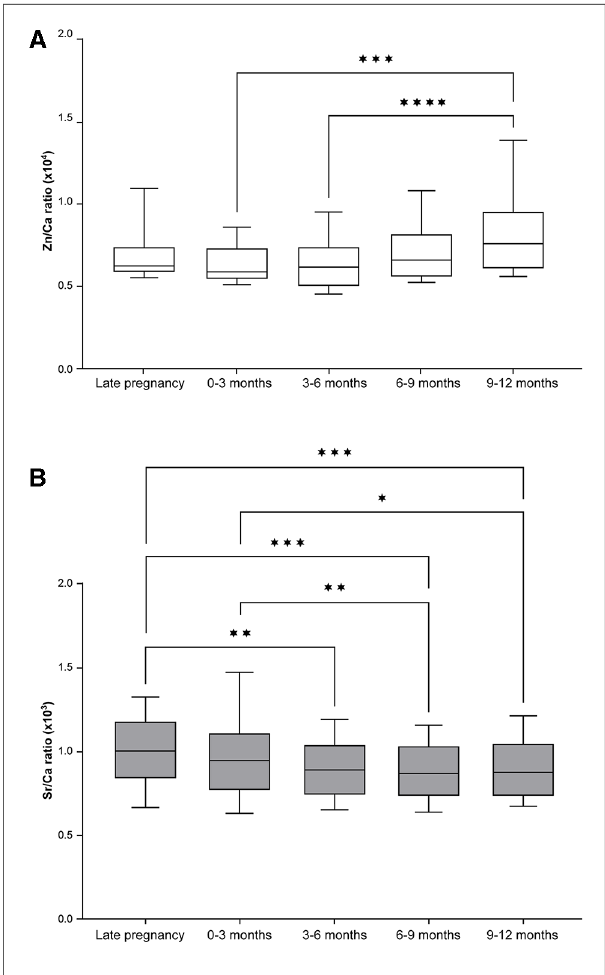
FIGURE 4 Zn and Sr distribution across different points in time during the development of deciduous teeth (median and 25th – 75th percentile with whiskers extending from smallest to largest value; n =18). ( A ) The Zn/Ca ratio differed signi fi cantly across time points (Friedman test, p < 0.001); *** p <0.001, **** p <0.0001 (Dunn ’ s post hoc test). ( B ) The Sr/ Ca ratio also differed signi fi cantly across time points (Friedman Test, p <0.001); * p <0.05, ** p <0.01, *** p <0.001 (Dunn ’ s post hoc test).